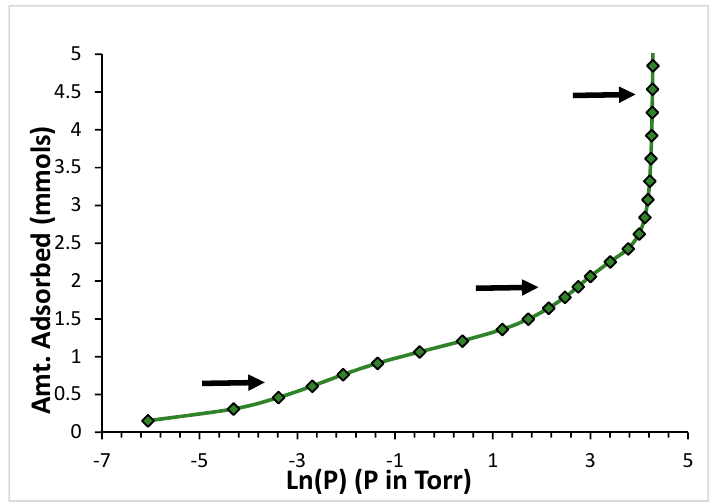
Figure 6. Adsorption isotherm for CF 4 on aggregates of open carbon nanohorns at T = 118.95 K. The arrows, from top to bottom, indicate saturation, sorption on weak binding energy sites, and sorption on strong binding energy sites present on the sorbent.